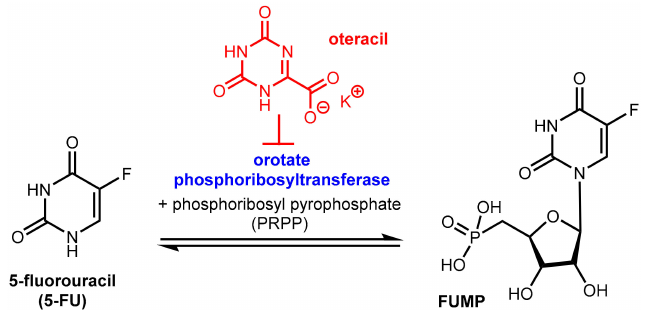
Figure 20. Function of the enzyme orotate phosphoribosyltransferase (OPRT) and its inhibition by oteracil (in red).